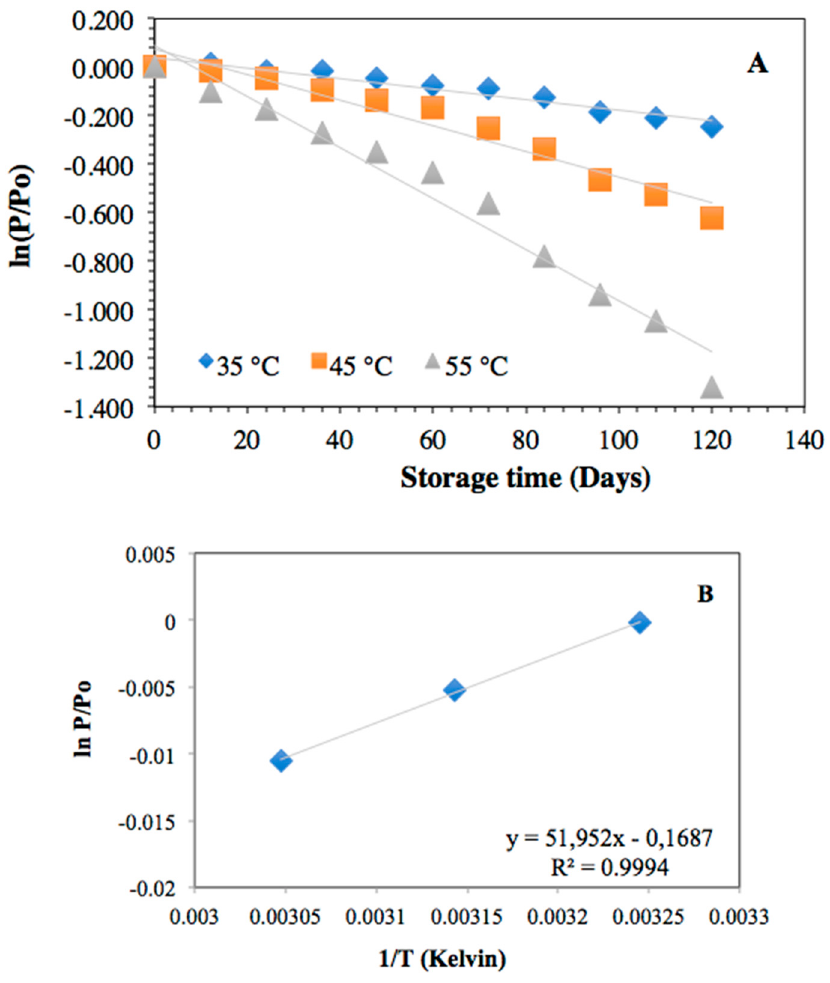
Figure 11. Thermal degradation kinetics at various temperatures of anthocyanins from H. macrocarpa powder and nanocellulose ( A ); Arrhenius plot of the degradation model during heating ( B ). Table 3. Kinetic parameters of anthocyanin and reducing capacity during heat treatment. Parameter